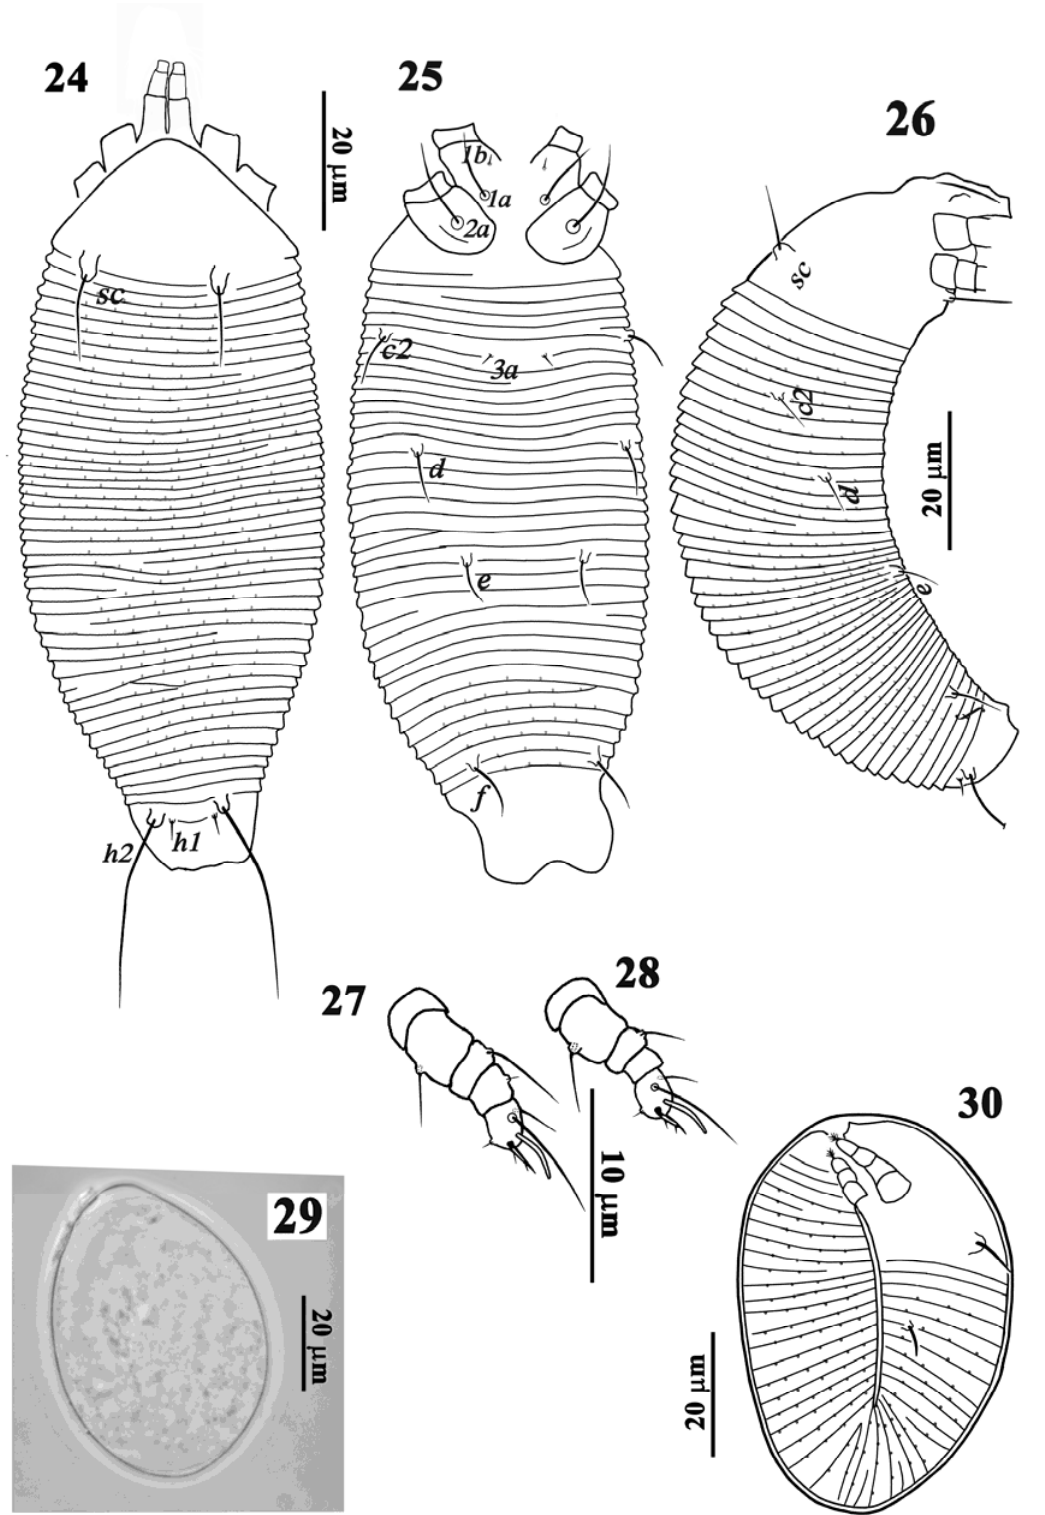
F IGURES 24-30. A. tristriatus (Nalepa) (Larva, egg, embryonic): 24. Dorsal view of larva; 25. Ventral view of larva; 26. Lateral view of larva; 27. Leg I; 28. Leg II; 29. Egg; 30.